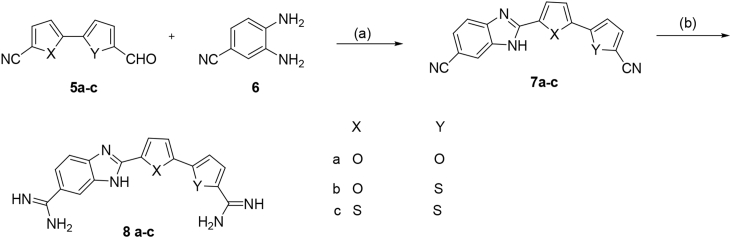
Reagenta and conditions: (a) 1,4-benzoquinone, EtOH, or Sodium bisulphite, DMF; (b) i-HCl gas/EtOH, ii-NH3 gas.